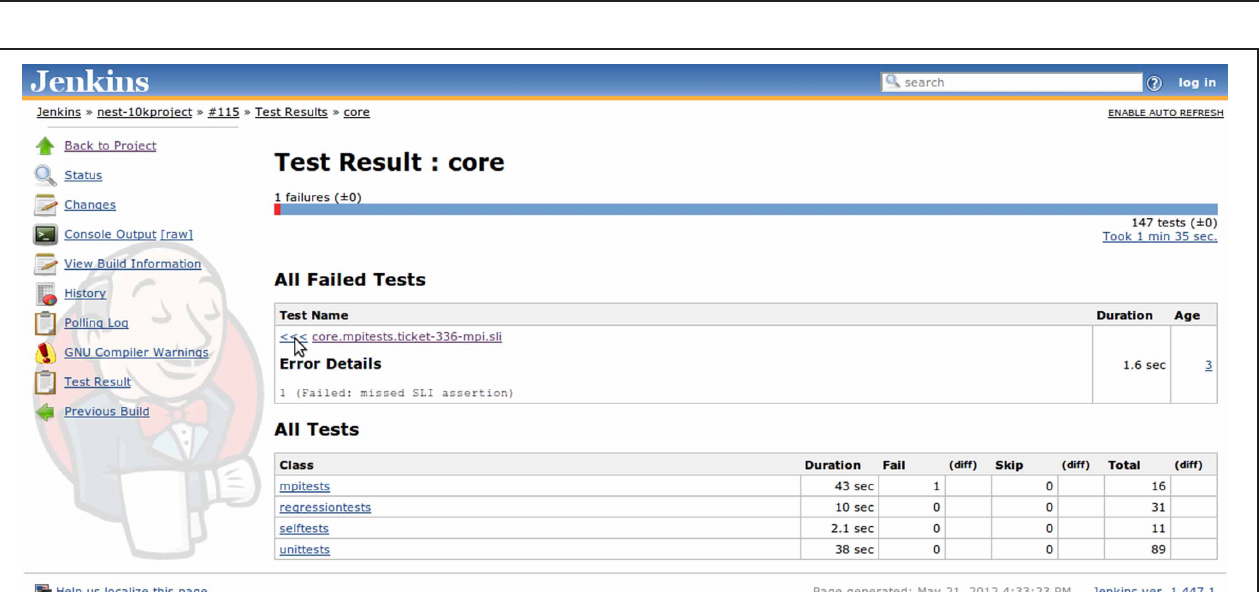
FIGURE 6 | Jenkins detailed test report view also featuring links to other details pages, such as build log (console output), information on which changes triggered the build, historical trends for test results, and warning analysis, etc. For failed tests, one can immediately check out the return code or exception raised (depending